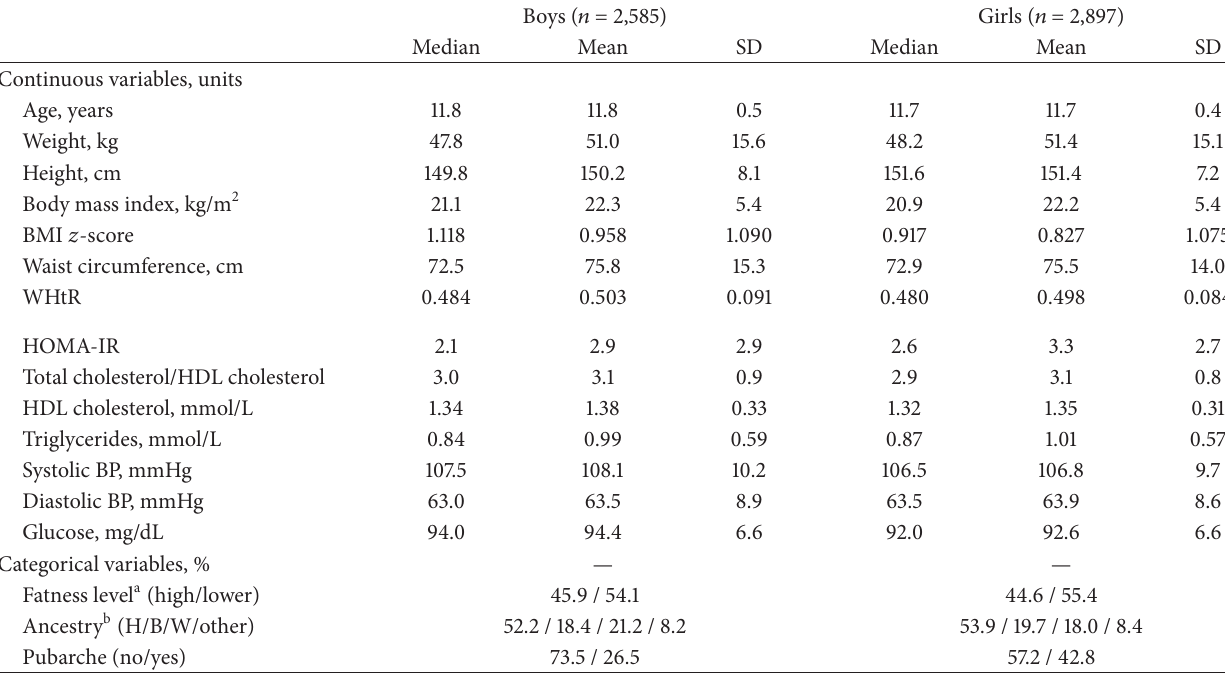
Table 1: Description of cross-sectional sample at grade 6 ( 𝑁 =